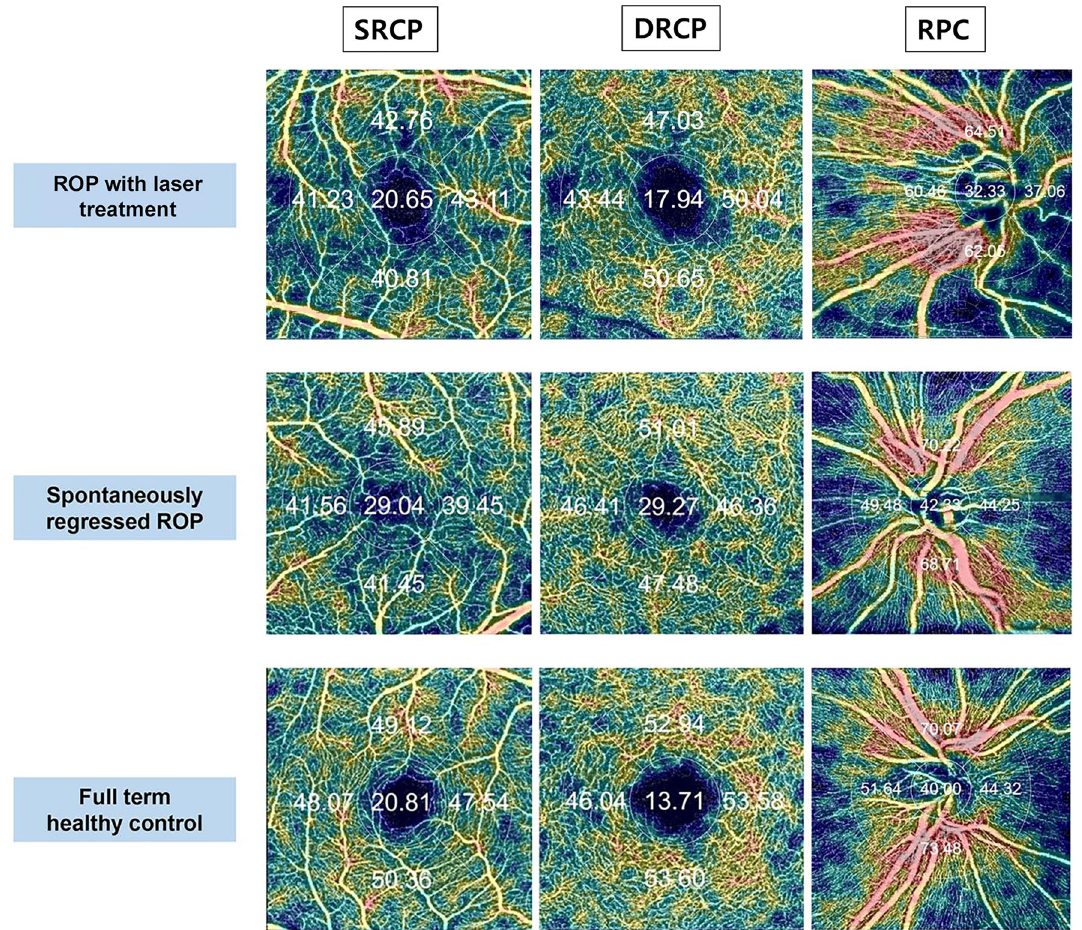
Figure 2. Typical parafoveal and peripapillary en-face example images of an eye with retinopathy of prematurity with or without treatment and a control eye by optical coherence tomography angiography. Color-coded flow maps reveal automated measurement of vessel density with percentage by auto-segmentation including the superficial retinal capillary plexus (SRCP), the deep retinal capillary plexus (DRCP), and the radial peripapillary capillary (RPC)